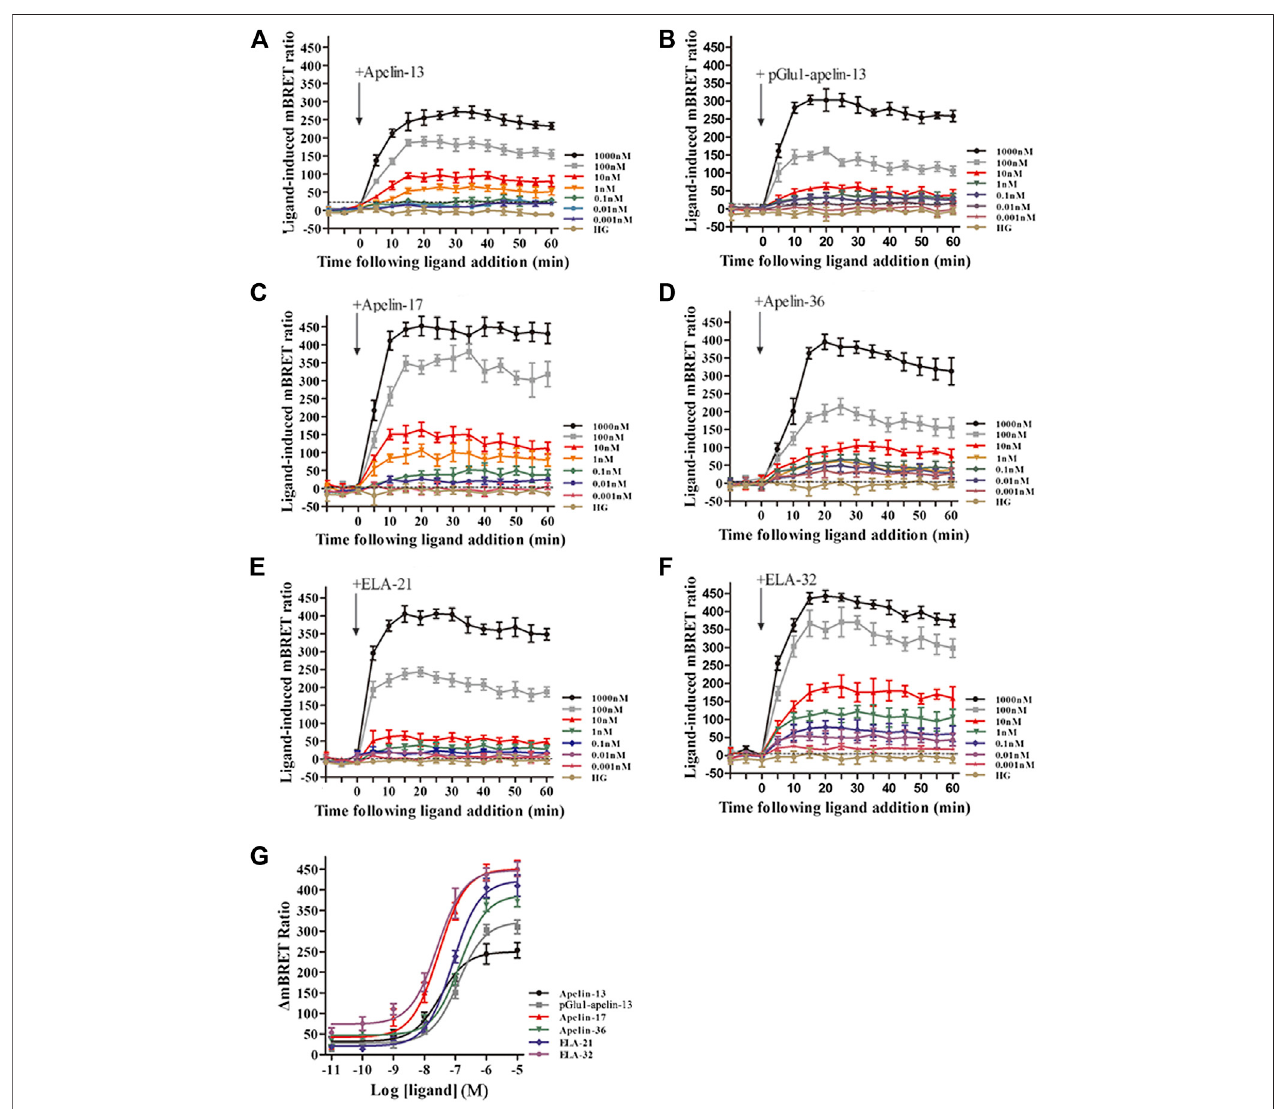
FIGURE 6 | The time-response curve (A – F) and dose-response curve (G) of interactions between APJ and β -arrestin1 induced by the six agonists in different concentrations,obtainedfromreal-timedynamicBRET determination. p < 0.05wasconsidered asstatistically signi fi cant.Controlgroup(HG,Cellswerestimulated with high glucose). In HEK293 cells expressing APJ and β -arrestin 1, the dose-response curves of the six peptides at 20 min were observed. The data represent means ± SEM of four independent experiments. Statistical analysis ( Supplementary Table S5 ).